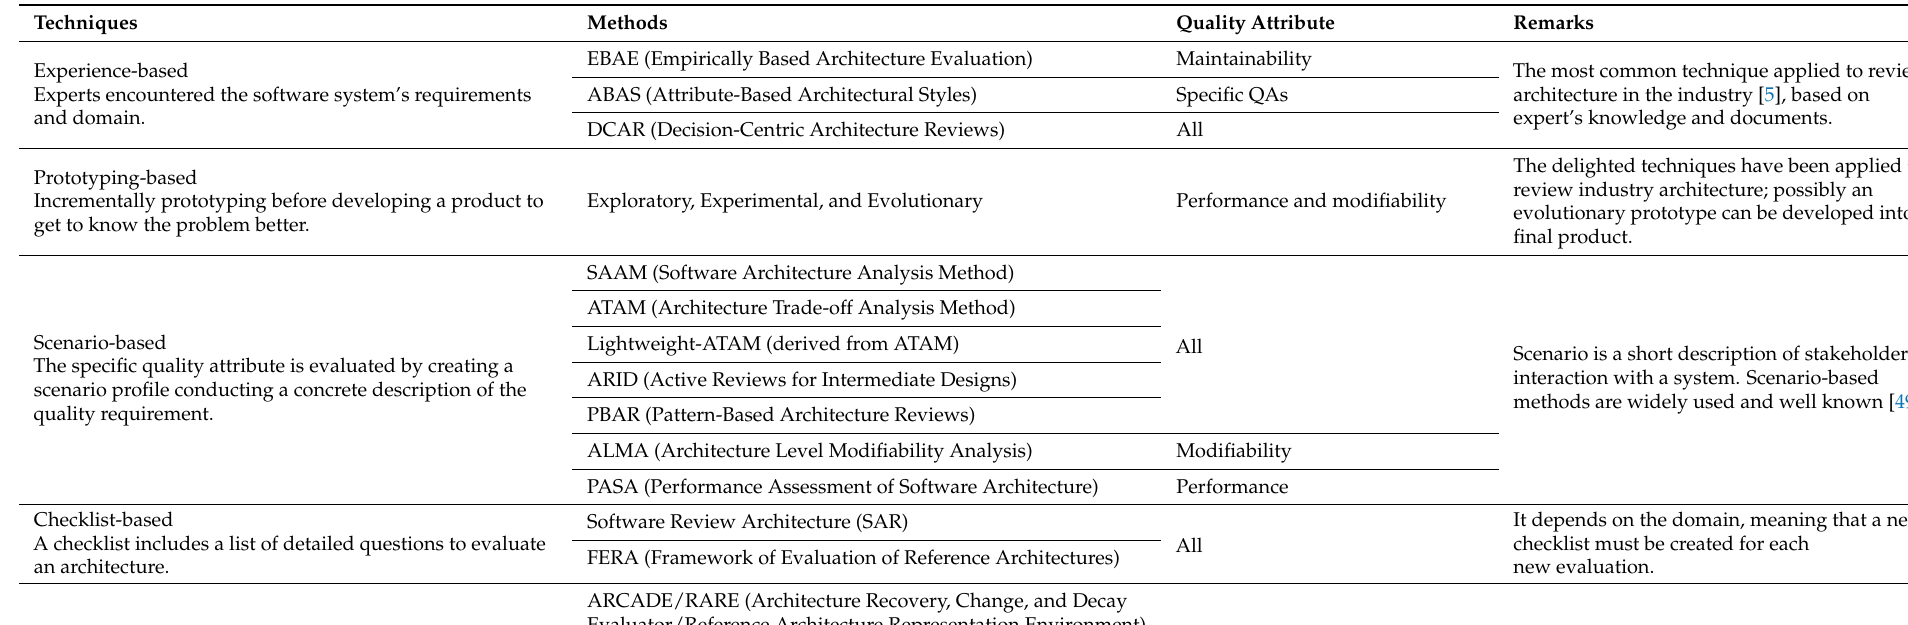
Table 2. SA evaluation